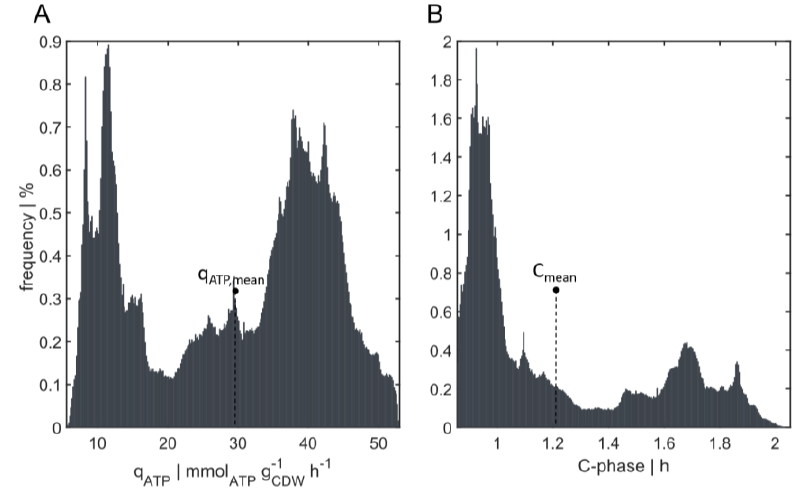
Figure 5. Distribution of C-phase duration and energy level. ( A ) Frequencies of cells with a specific adenosine triphosphate (ATP) consumption rate (q ATP ) tracked for 20 s. Average value of q ATP,mean = 29.31 mmol ATP · g CDW−1 · h −1 . Range of the x-axis from q ATP,min = 5.57 mmol ATP · g CDW−1 · h −1 to q ATP,max = 52.98 mmol ATP · g CDW−1 · h −1 . ( B ) Frequency of cells having a specific duration of replication (C-phase). Average C-phase duration of C mean = 1.21 h. Range of the x-axis from C min = 0.86 h to C max = 2.05 h. Counts were divided into 300 bins.